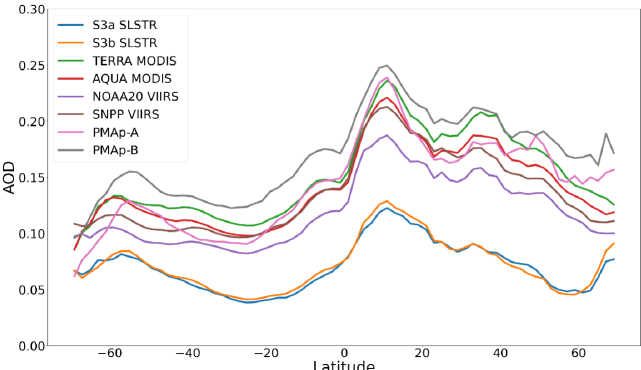
Figure D1. Latitude cross-section of temporal mean satellite AOD for the MAM period over ocean.